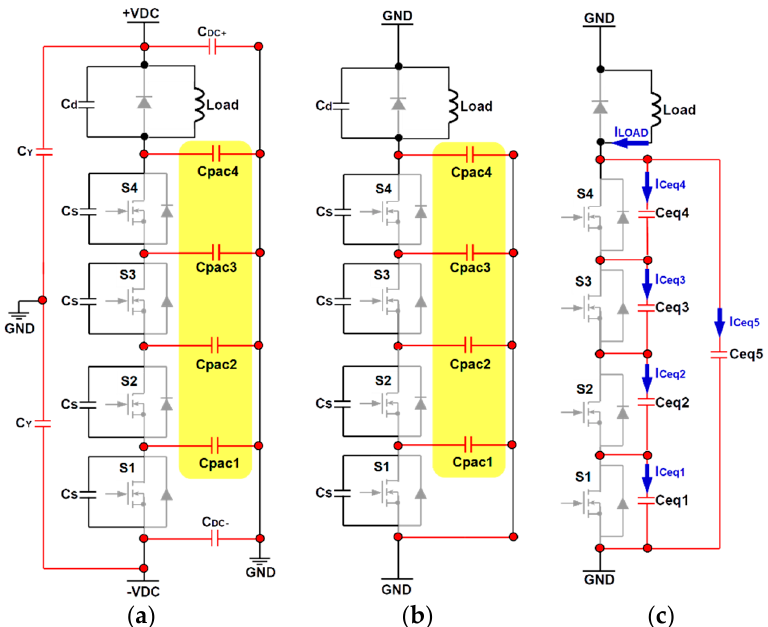
Figure 3. Equivalent electrical circuits for four series-connected devices ( a ) and its simplified circuits ( b ) and ( c ).